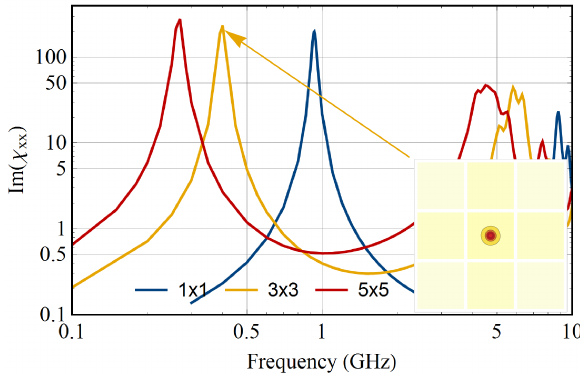
Figure 5. Ordered arrays of nanoplatelets with a centered macro- vortex state and a vortex core. Array size dependence of the Im( χ xx ) spectrum. The interplatelet spacing is δ = 3 nm. The inset maps the local susceptibility (Im( χ + ( x ,y )) of the 3 × 3